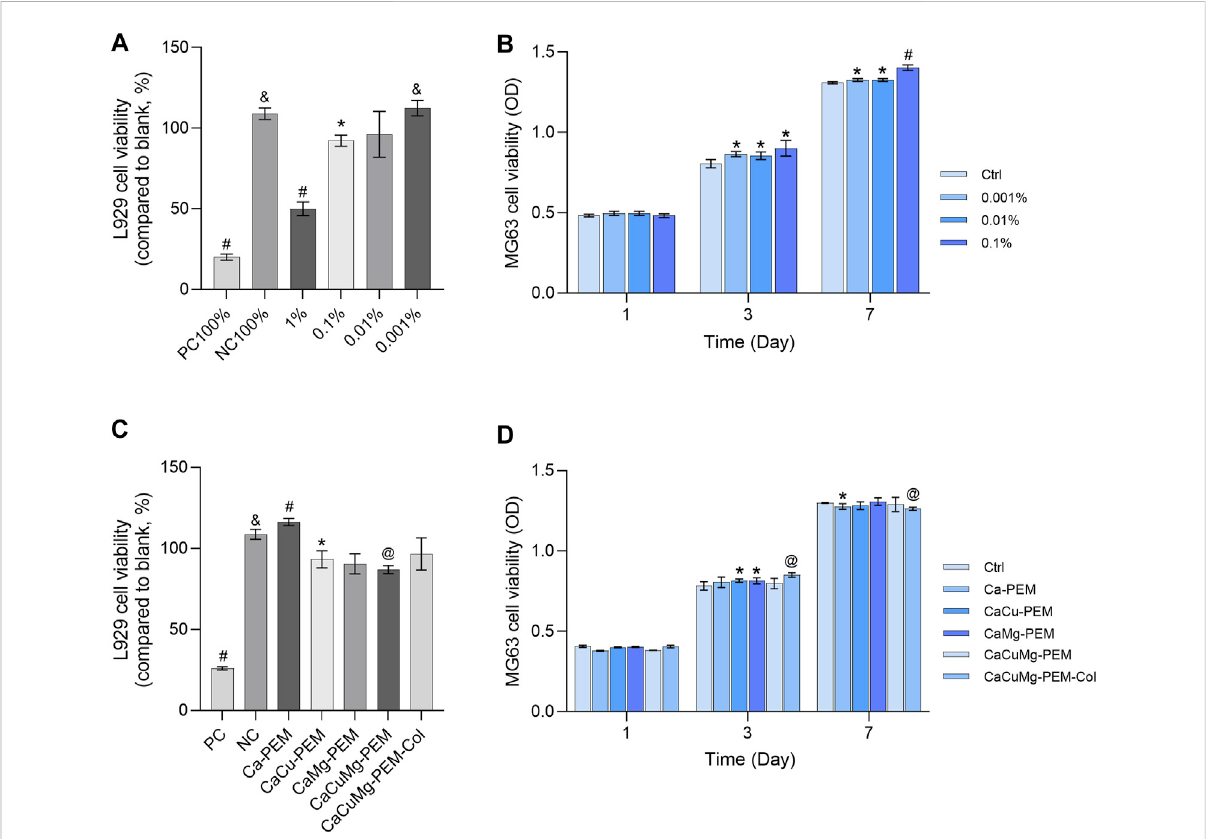
FIGURE 6 In vitro cytotoxicity of control samples (PC, positive control; NC, negative control) and (A) extract of CaCuMg-PEM-Col in a series of concentrations, and (C) extract of Ca-PEM, CaCu-PEM, CaMg-PEM, CaCuMg-PEM and CaCuMg-PEM-Col microcapsules towards L929 cells. Cell viability of osteoblast-like MG63 cells cultured with extract of microcapsules determined by CCK-8 assay at 1, 3, 7, 10 and 14 days: (B) culture medium supplemented with extract of CaCuMg-PEM-Col microcapsules in different concentrations; (D) culture medium supplemented with 0.1% extracts of Ca-PEM, CaCu-PEM, CaMg-PEM, CaCuMg-PEM and CaCuMg-PEM-Col microcapsules. (mean ± SD, n = 6; Paired t -test, * p < 0.05, & p < 0.01, @ p < 0.001, # p < 0.0001, indicated that there was a signi fi cant difference of cell viability in comparison to blank